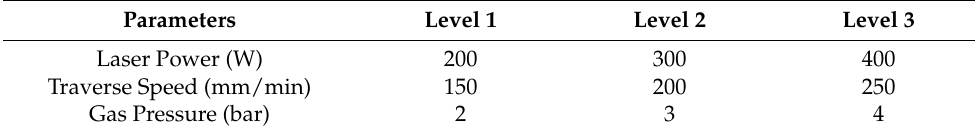
Table 1. Input parameters levels for specimen thickness of 2 mm, in laser beam cutting process.